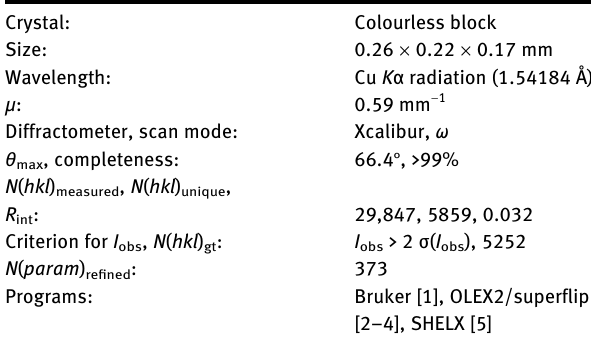
Table  : Data collection and handling.